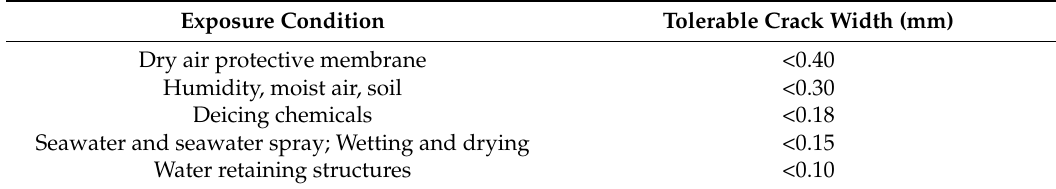
Table 5. Tolerable crack widths for exposure conditions of ACI 224R-90